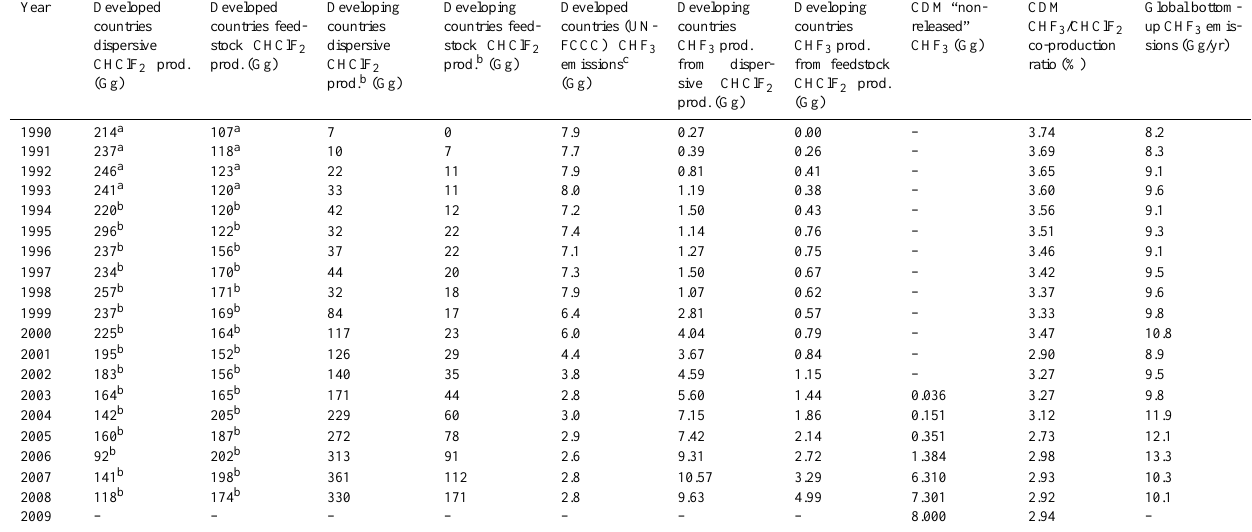
Table 4. HCFC-22 (CHClF 2 ) production and HFC-23 (CHF 3 ) production, emissions and incineration for developing countries, developed countries and global total. The sources of HCFC-22 production data are indicated by footnote letters “a”–“c” following the numerical